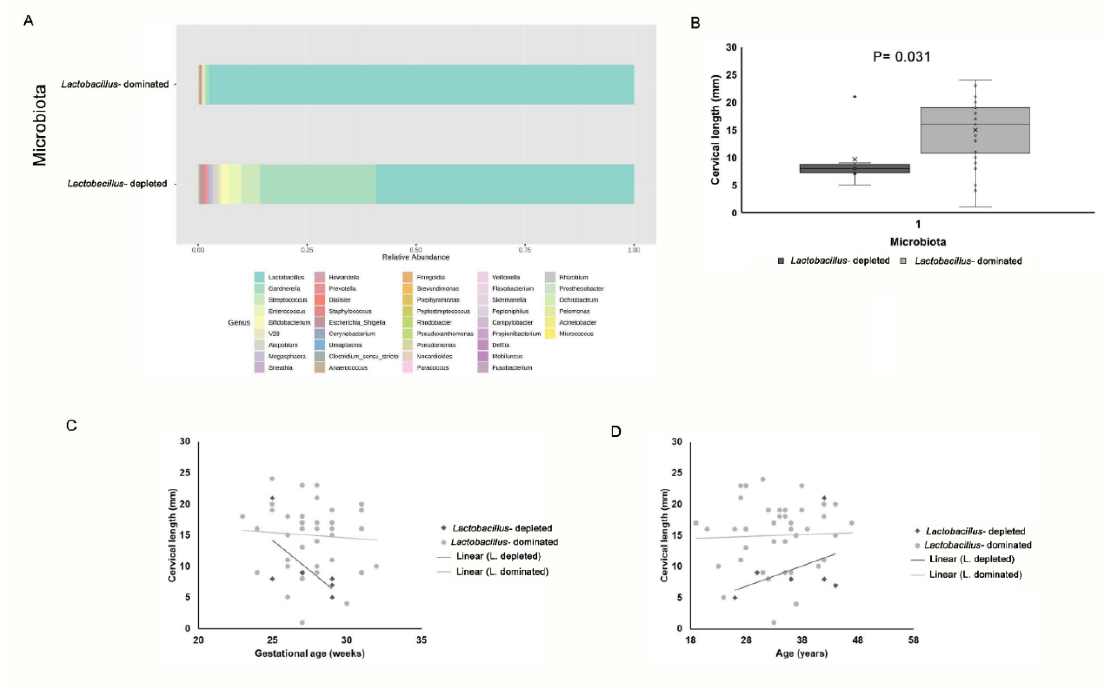
Figure 1. Survey of vaginal microbiota and correlation with cervical length. ( A ) Overview of vaginal microbiota grouped by Lactobacillus -depleted and Lactobacillus -dominated microbiota types. In each barplot, the percentage of relative abundances at the genus level is showed. ( B ) Differences in cervical length between women with Lactobacillus -depleted microbiota and women with Lactobacillus -dominated microbiota. Data are presented as box and whisker plots, with boxes extending from the 25th to 75th percentile and horizontal lines representing the median. Whiskers extend 1.5 times the interquartile range from the 25th and 75th percentile. Statistical analysis was performed by Mann–Whitney assay. p -value < 0.05 was considered as significant. ( C , D ) Analysis of covariance (ANCOVA) with grouping variables and covariates ( C ) age and ( D ) gestational age at sampling. Scatter plot with regression lines for the two groups ( Lactobacillus -depleted / Lactobacillus -dominated microbiota).